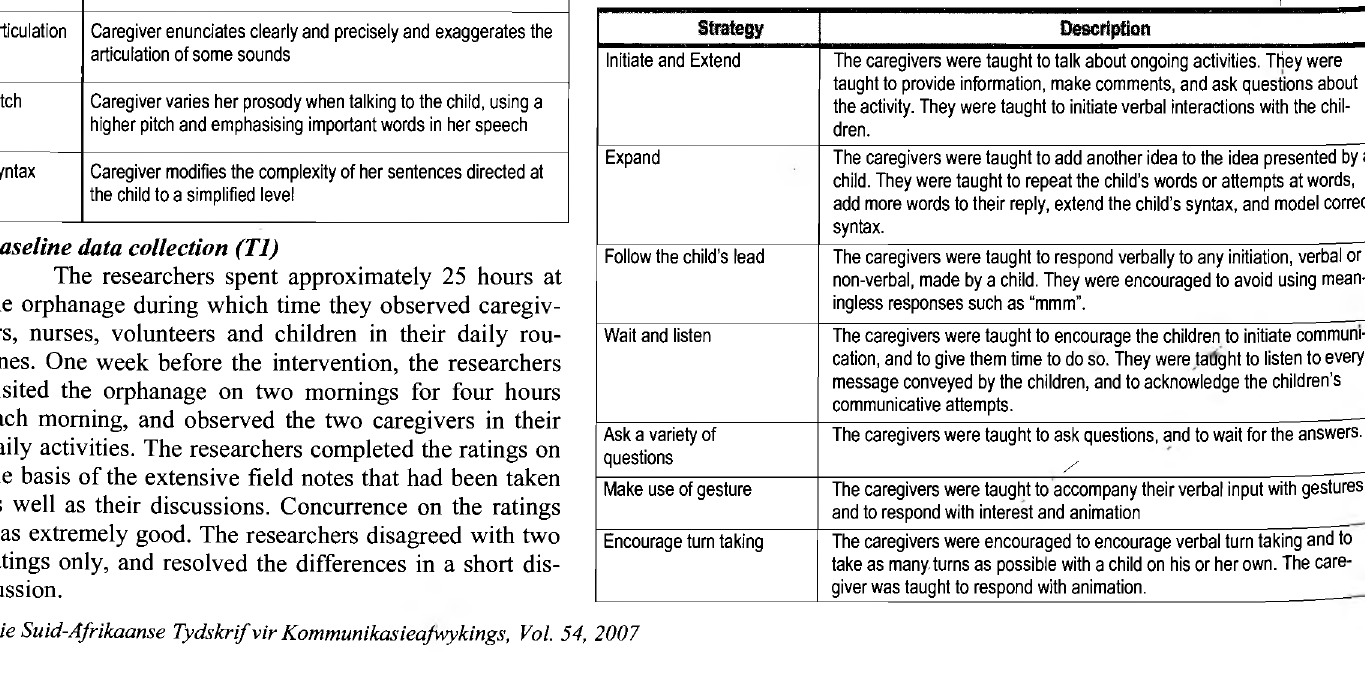
Table 3: Responsiveness strategies included in the programme (Adapted from Gi­ rolametto and Weitzman, 2002; Girolametto et al, 2003; and Weitzman,